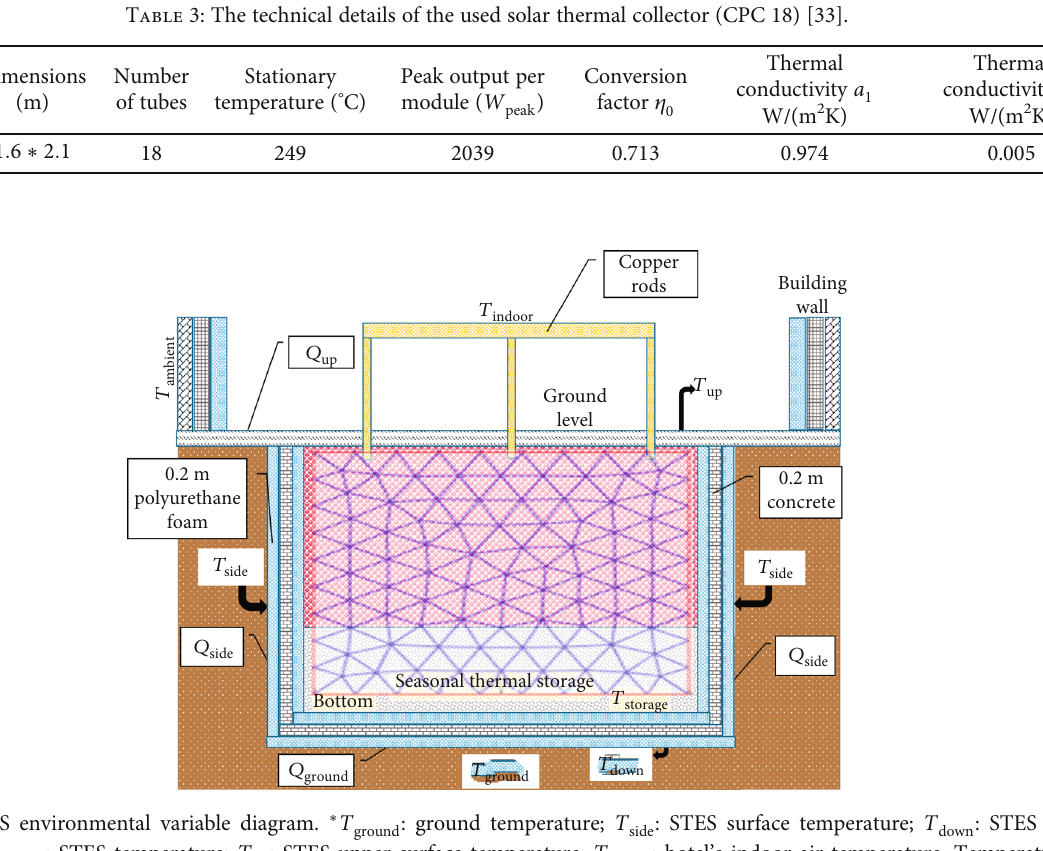
: STES bottom down